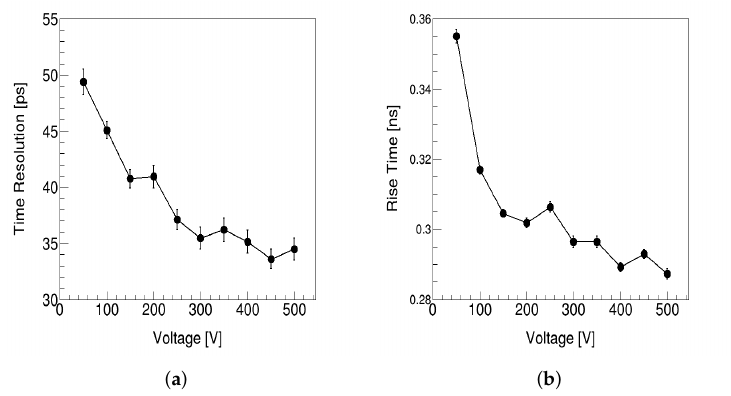
Figure 5. ( a ) Time resolution versus voltage. ( b ) Rise time versus